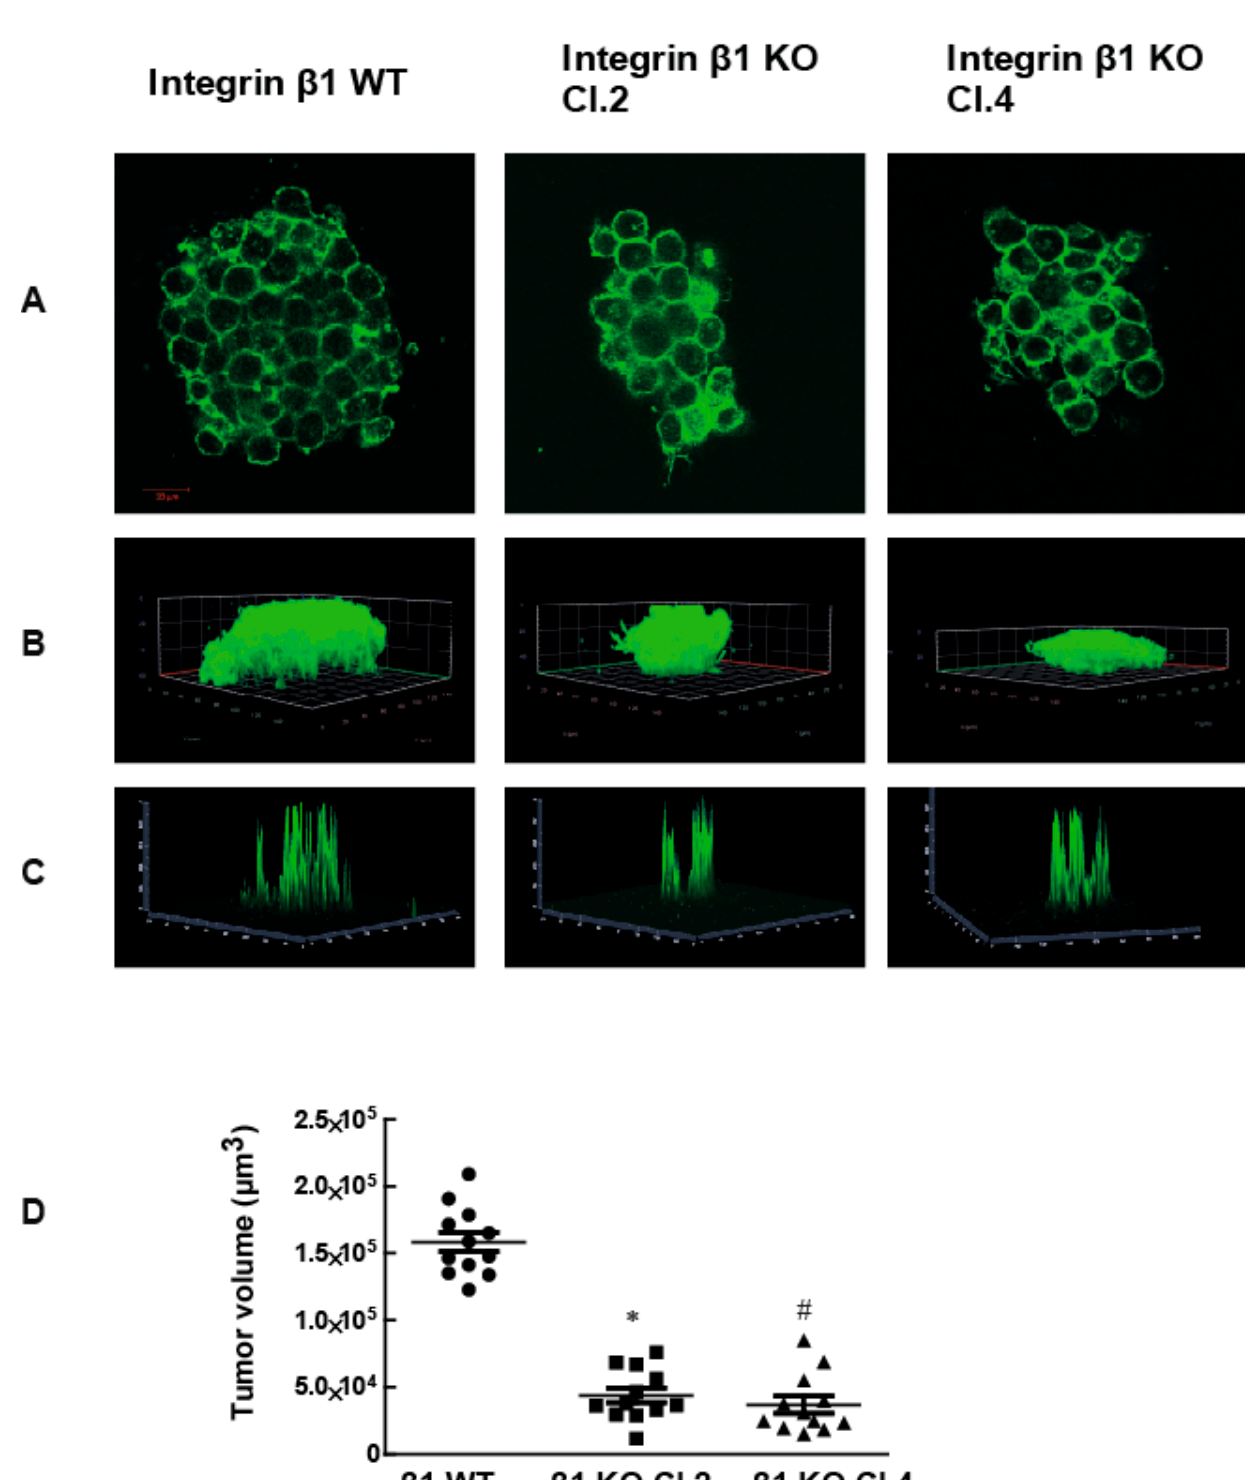
Figure 2. The deletion of the β 1 integrin gene from MIA PaCa-2 cells decreases tumor growth on the 3D matrix. ( A ) Tumors formed by MIA PaCa-2 cells expressing the integrin β 1 gene and cells where the integrin β 1 gene removed were stained for F-Actin (phalloidin, green) to estimate the size of the tumor. Scale bar 20 µm. ( B ) 3D projection of z stack indicate the tumor size. ( C ) The projection of the intensity of actin staining (view 2.5D) and (D) Tumor volumes were measured after the acquisition of z-stack slices with confocal microscope. These images were processed using ImageJ software to determine the volume. One-way ANOVA was performed with Bonferroni’s test to compare between groups. * indicates a statistically significant difference between WT and Clone 2, n = 12, p < 0.001). # indicates the statistically significant difference between groups WT and Clone 4 n = 12, p < 0.001. Data shown are mean ± SEM, unit: µm 3 .